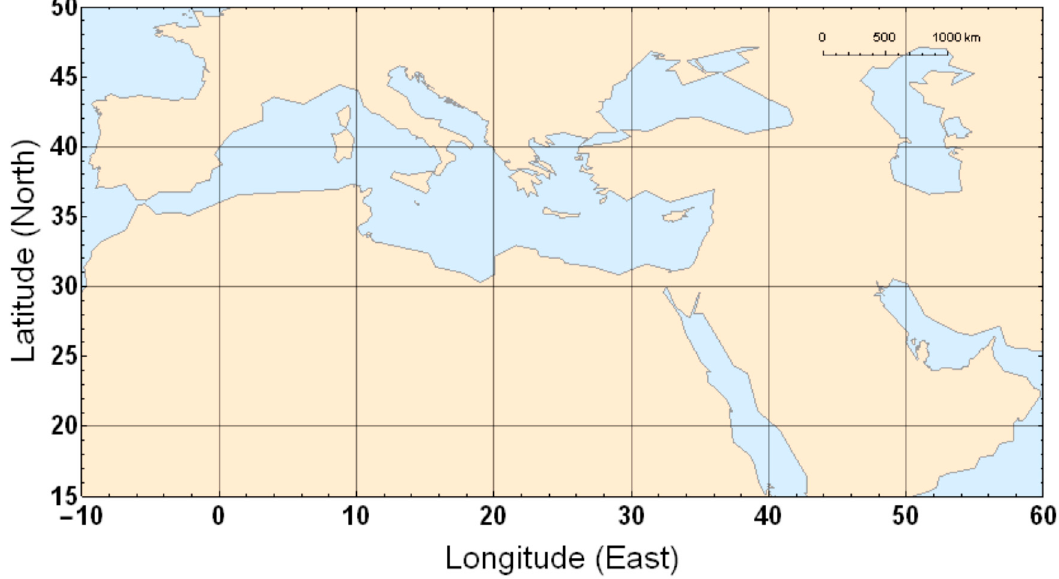
Figure 1. The Mediterranean, Middle East and North Africa (MedMENA) region.